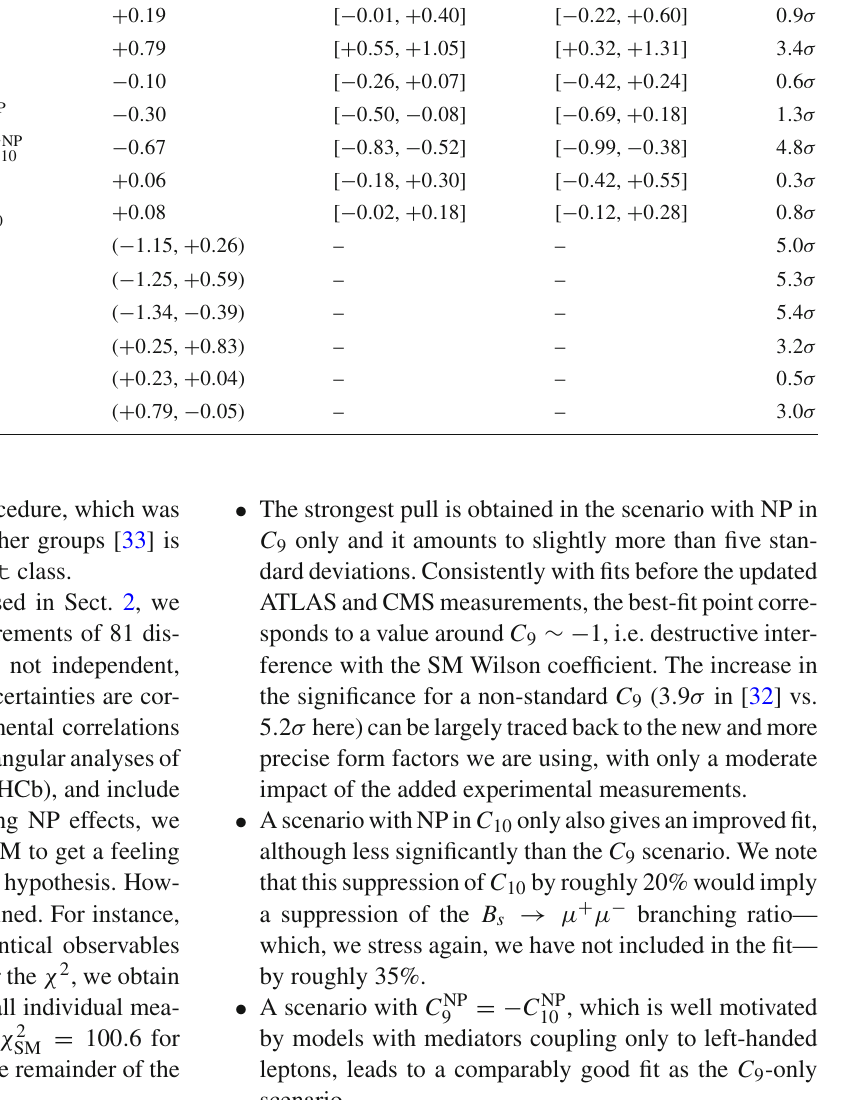
Table 1 Best-fit values and pulls in sigma between the best-fit point and the SM point for scenarios with NP in one or two Wilson coefficients. For the one-dimensional cases, we also show the 1 and 2 σ best-fit ranges. For two of the two-dimensional cases, the best-fit regions are shown in Fig.